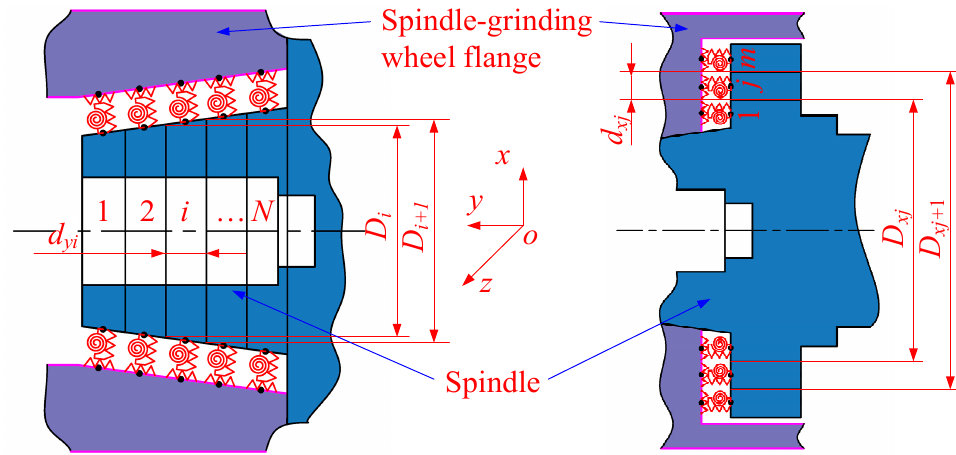
5 of 21 Figure 2. Applied load and coordinate system of the spindle–GWF: ( a ) applied load of the GWF; ( b ) local coordinate system of the spindle–GWF interface. 2.2. Spindle–GWF Interface Contact Stiffness Calculation The spindle–GWF interface is modeled by a spring [15,20]. The stiffness of the spin- dle–GWF interface is equivalent to the spring total stiffness. According to the actual mo- tion of the spindle and the GWF, the spindle has three degrees of freedom: tangential translation, normal translation and mutual rotation. The contact stiffness of the spindle– GWF can be equivalent to axial stiffness, radial stiffness and angular stiffness. Yoshimura proved [30] that the dynamic performances of the interface per unit area are the same for the same average contact pressure. The spindle–GWF interface is the two-sided contact that includes a tapered surface and an end surface. The contact pressure of each unit area on the contact surface is different, so it does not meet the conditions for use of the Yoshi- mura method. The finite element method is used to divide the tapered interface into N elements and the end interface into m elements, as shown in Figure 3 , where d yi is the ele- ment length; D i and D i+1 are the diameters of the i -th and i +1-th node of the taper part of